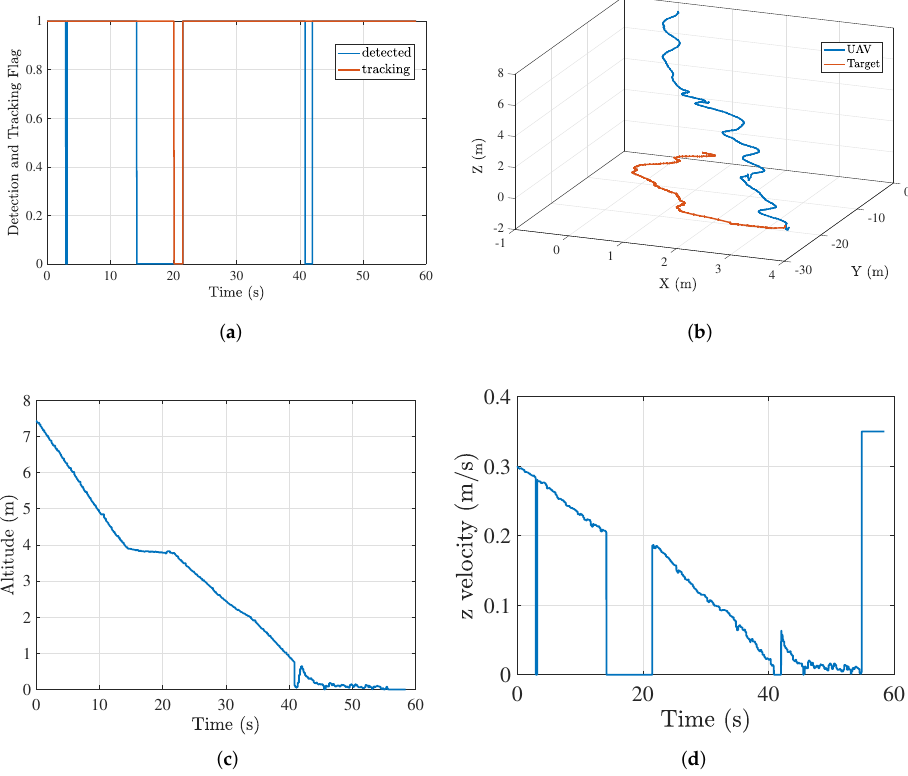
Figure 17. Moving target occlusion results. ( a ) Target detected and tracking flag; ( b ) trajectory followed by UAV to land on target; ( c ) altitude profile of UAV; ( d ) V z profile of